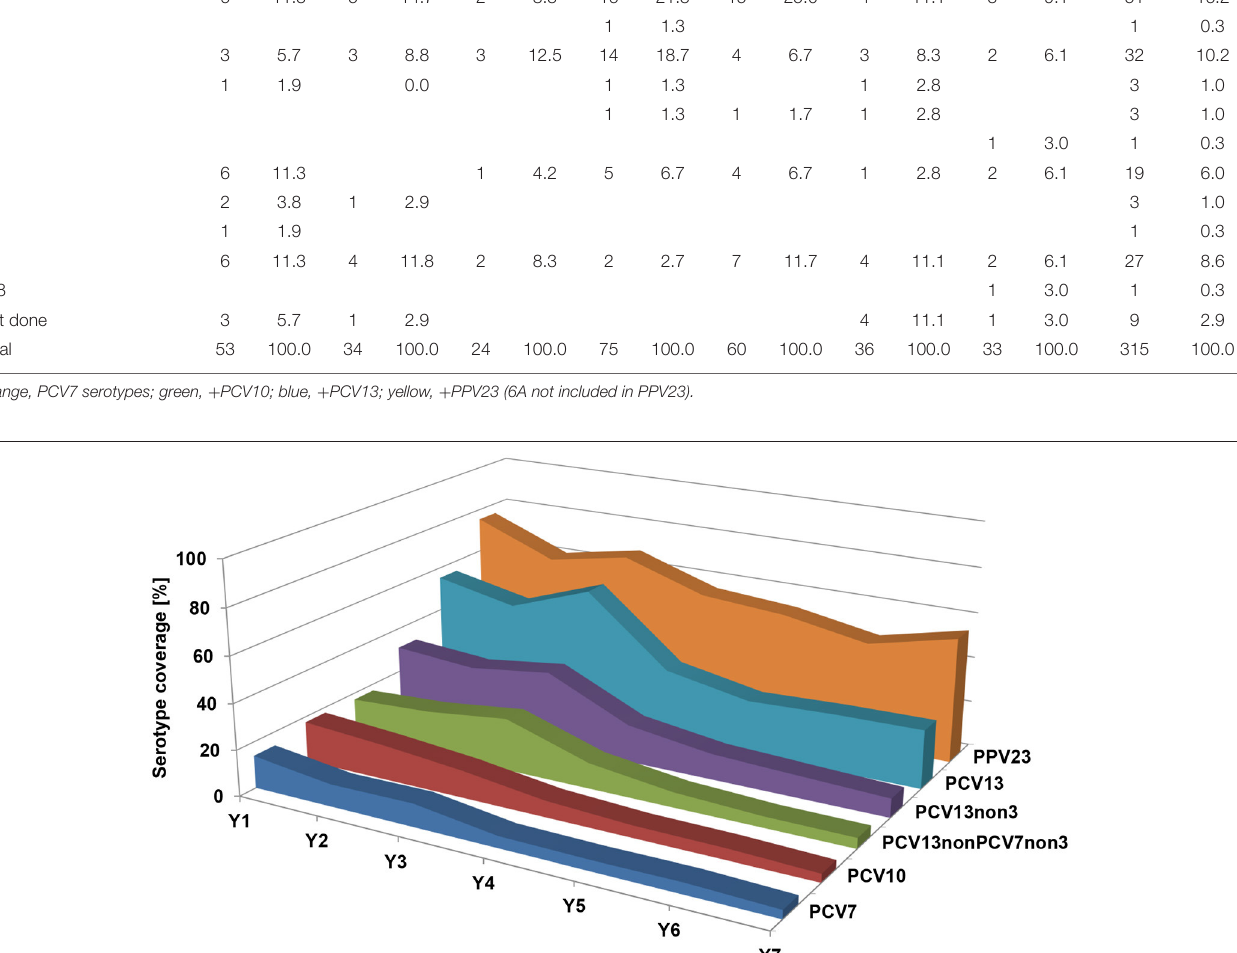
type in MEF, and among PCV13-vaccinated children ( n = 58), 51.7% had a PCV13 serotype (PCV10, combinations, vaccine unknown: n = 12). Among non-vaccinated children ( n = 27), the percentages were 14.8 and 70.4% ( Figure 7 ). Carriage levels of vaccinated and unvaccinated patients were not different from each other: S. pneumoniae : vaccinated 50.3%, non-vaccinated 55.0%; H. influenzae : 39.3/32.6%; S. pyogenes : 17.4/16.1%; and M. catarrhalis :